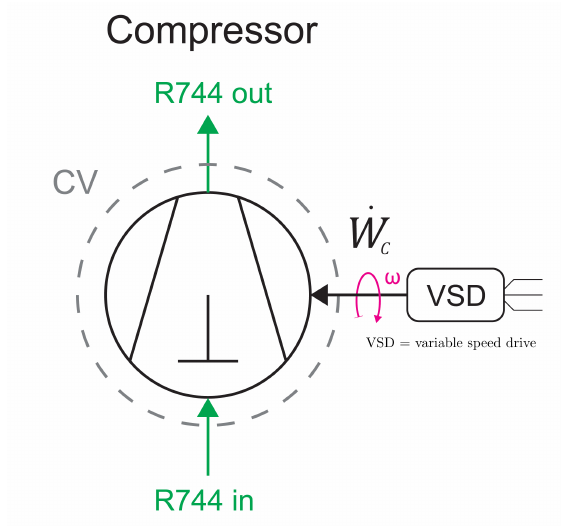
Figure A2. Compressor component with its